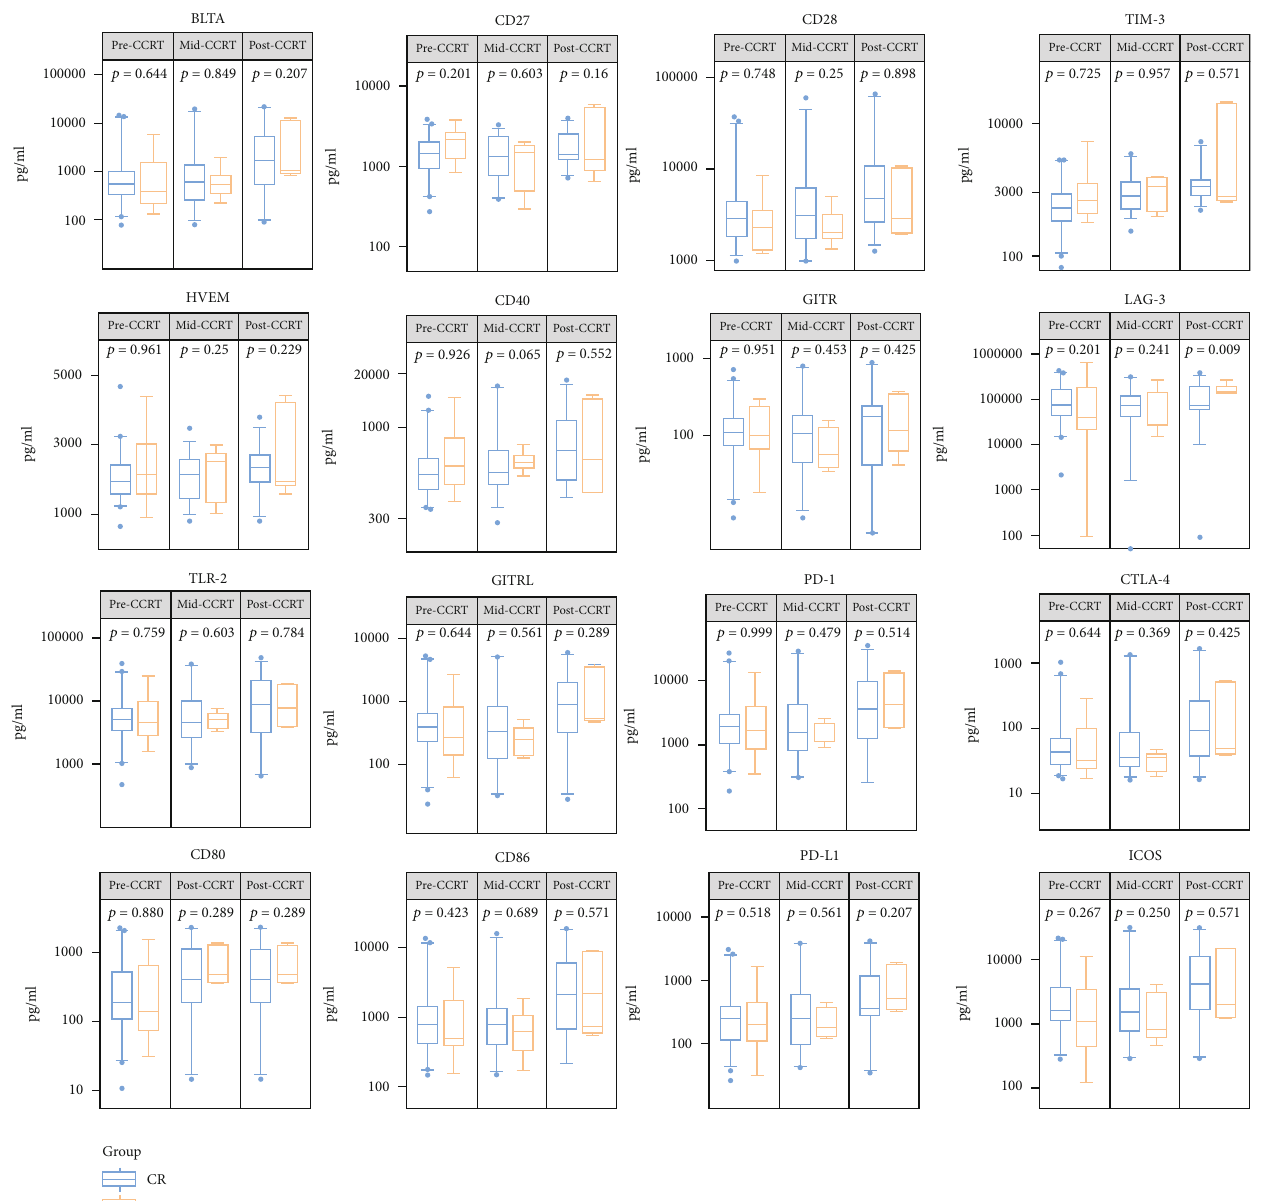
Figure 5: Di ff erences in the sICPs between the CR and PR/SD groups patients. The level of sICPs was compared between the CR and PR/SD group patients before, during, and after CCRT. The P values were calculated using the Kolmogorov-Smirnov